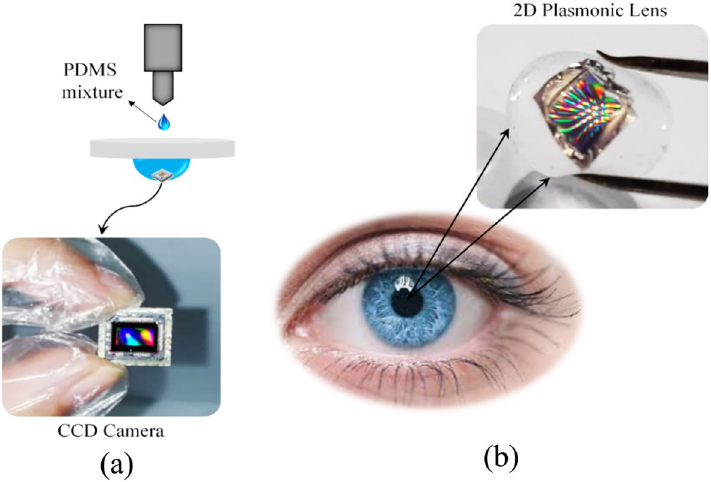
Figure 2. ( a ) A schematic of the fabrication process of the proposed 2D plasmonic contact lenses based on PDMS, and ( b ) the real image of the fabricated 2D flexible plasmonic contact lens.